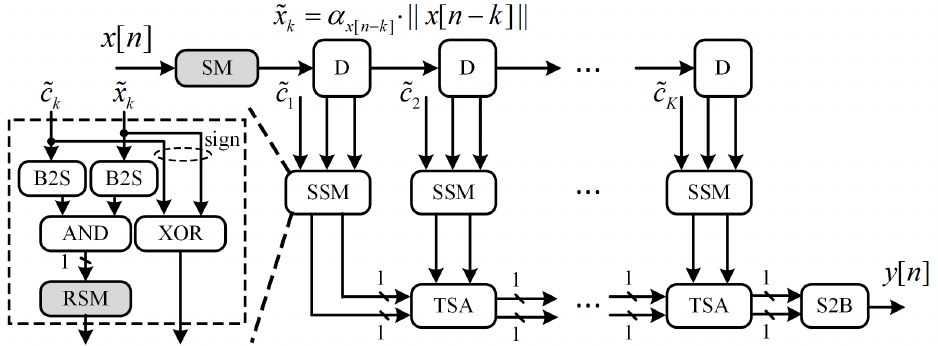
Figure 8. Hardware architecture of the proposed SFIR filter with